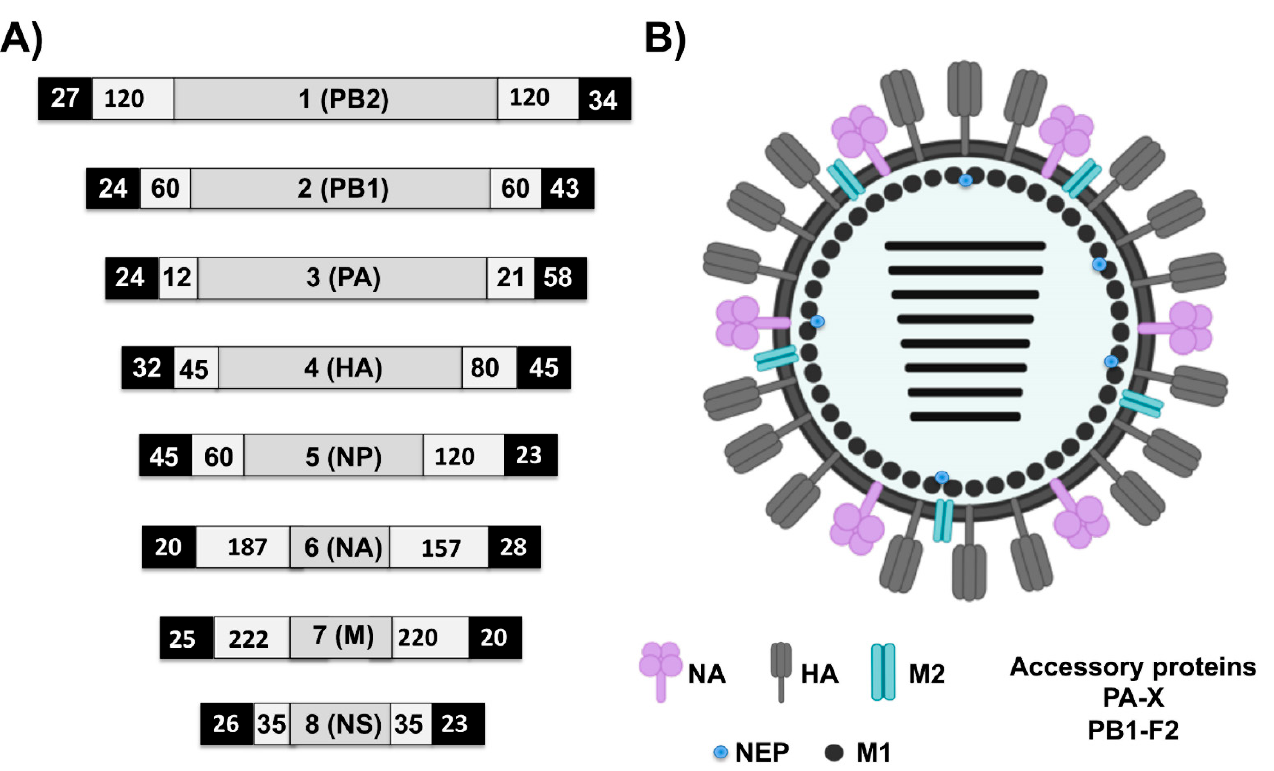
Figure 3. Schematic representation of an influenza A virus (IAV) genome organization and virion structure. ( A ) The genome organization of the eight negative-sense RNA gene segments (PB2, PB1, PA, HA, NP, NA, M, and NS) of IAV. All segments 1—8 (as in Table 2) are numbered according to the conventional representation from 3 ′ to 5 ′ . The black boxes at the end of each viral segment indicate the noncoding regions (NCR). White boxes show the packaging signals present at the 3’ and 5 ′ ends of each gene segment. ( B ) The basic architecture of IAV contains envelope surface glycoproteins HA, NA, and M2 ion channel protein, all embedded within the host cell-derived lipid bilayer envelope. Immediately underneath the envelope is a well-organized layer of M1 and NEP proteins surrounding the eight negative-sense viral RNA segments.